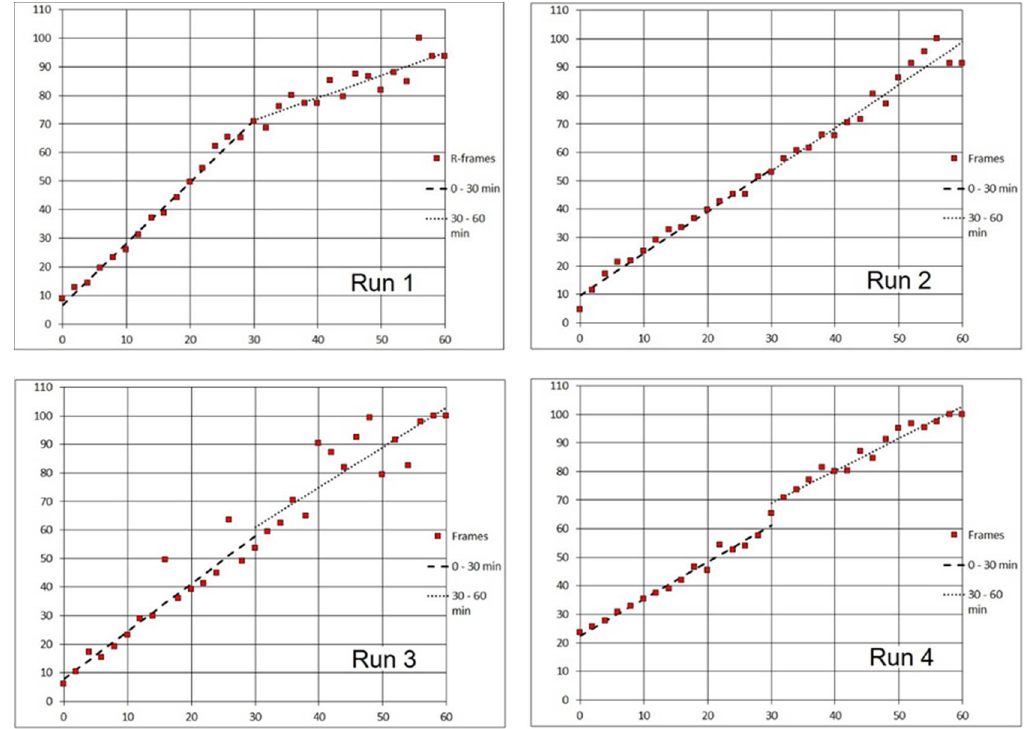
Figure 13. Time-lapse records of PI (red) fluorescence signal from a mixed biofilm of S. epidermidis and E. coli exposed to Product “A” (Run 1–4; same data as Figure 10). Horizontal axis: time in minutes. Vertical axis: % of maximum frame luminance. Linear best fit for two 30-min segments after the delivery of product. Table 2. Estimates of the signal doubling time of PI (red) fluorescence emission in four assays of Product “A”.